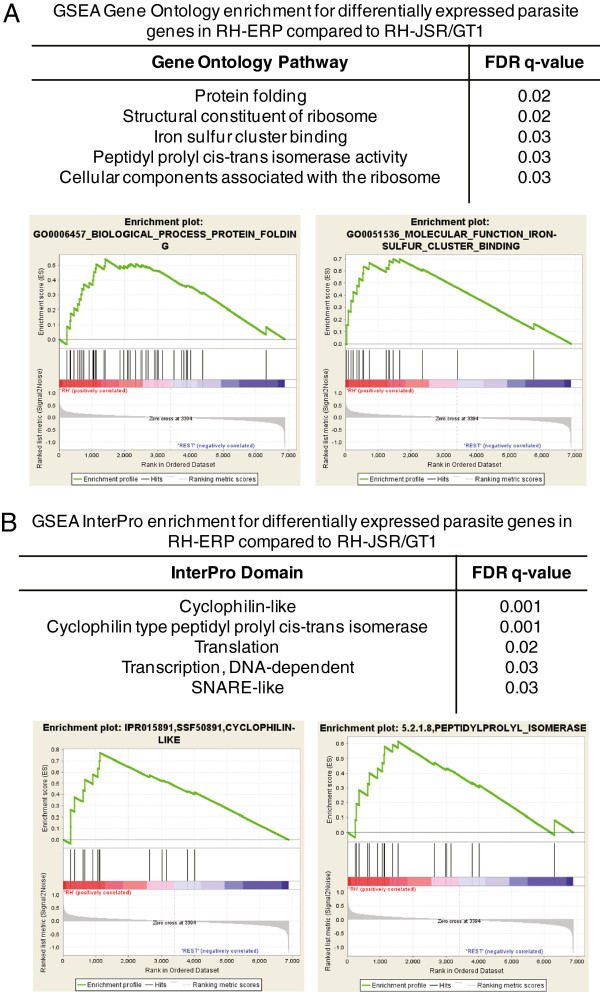
Differential parasite gene expression between type I strains. (A) The top five enriched Gene Ontology (GO) pathways using GSEA in differentially expressed parasite genes in RH-ERP compared to RH-JSR/GT1 and the corresponding GSEA diagrams, using Toxoplasma genesets with Gene Ontology annotations. The GSEA diagrams show the enrichment score (green line), which reflects the degree to which that particular gene set (header above) is overrepresented in the differentially expressed genes between RH-ERP and RH-JSR/GT1 (ranked by their differential expression values). The middle portion of the diagram shows where the members of the particular gene set appear in the ranked gene list. The bottom portion of the diagram shows the value of the ranking metric, which measures the correlation of a gene with upregulation (positive value) or downregulation (negative value) in RH-ERP compared to RH-JSR/GT1. (B) The top five enriched InterPro domain using GSEA in differentially expressed parasite genes in RH-ERP compared to RH-JSR/GT1 and the corresponding GSEA diagrams, using Toxoplasma genesets with InterPro annotations.